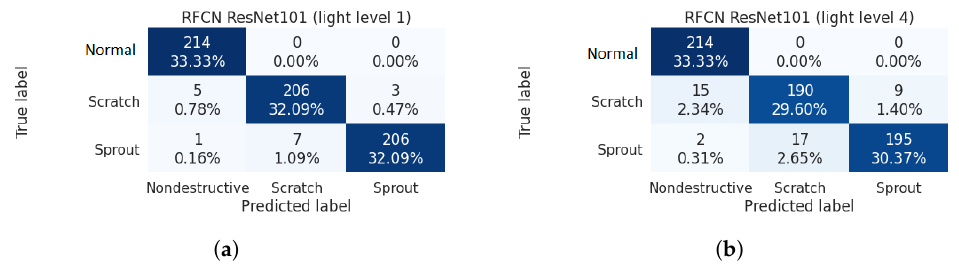
Figure 14. Confusion matrix of scenario three for the OOS test set: ( a ) light level 1 ( b ) light level 4. Table 5. Effect of light intensities on model performance for the OOS test